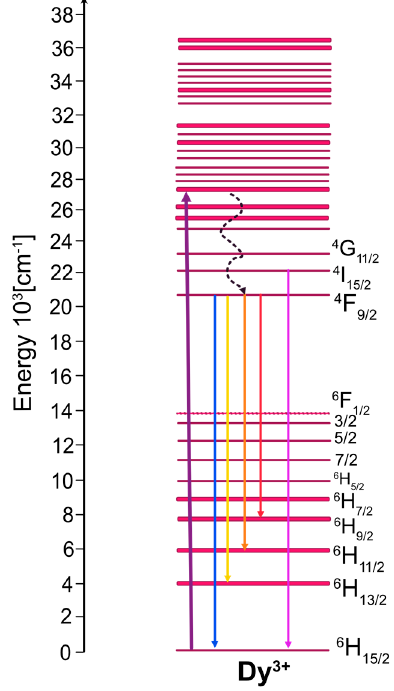
Figure 1. Energy levels scheme of Dy 3+ .